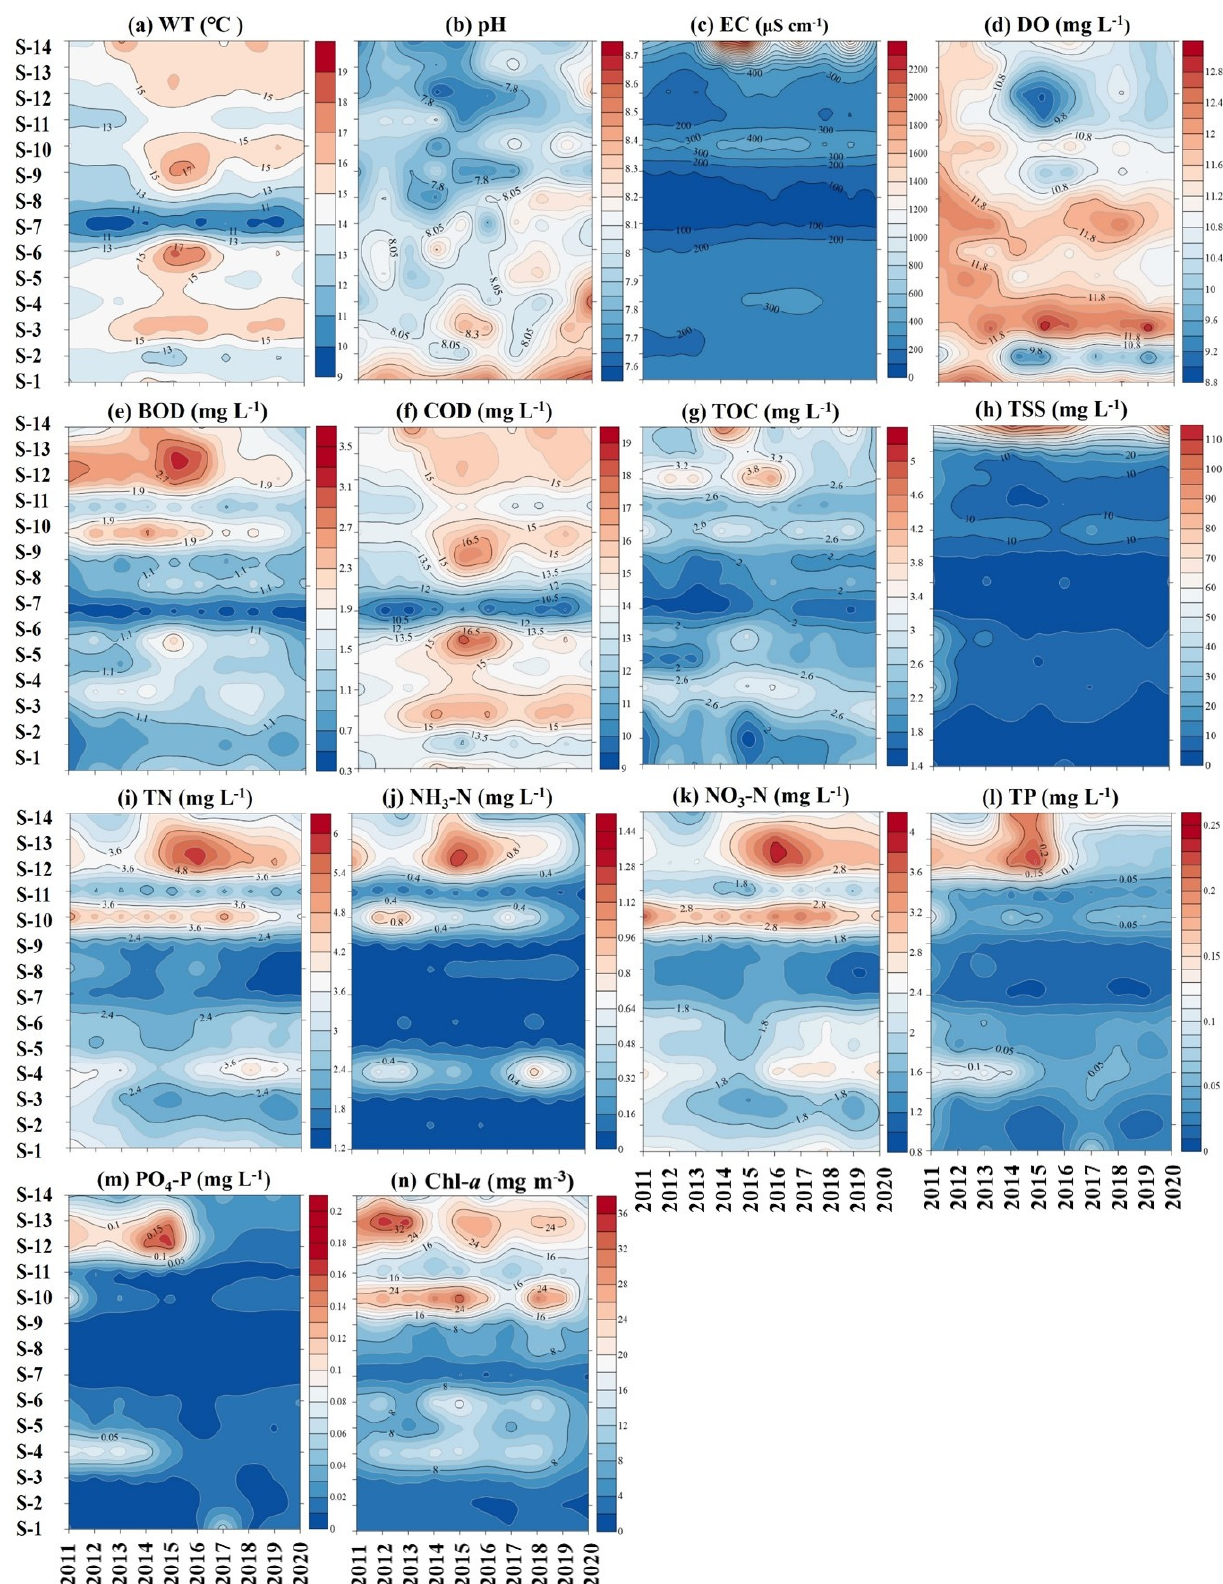
Figure 3. Temporal and spatial variation of water quality parameters in the monitoring sites of Han River Basin, South Korea.